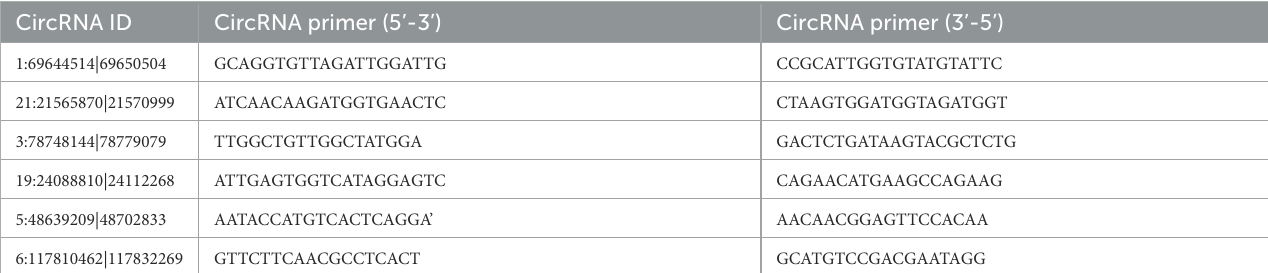
TABLE 2 Primers for qPCR validation of RNA-seq analysis results.